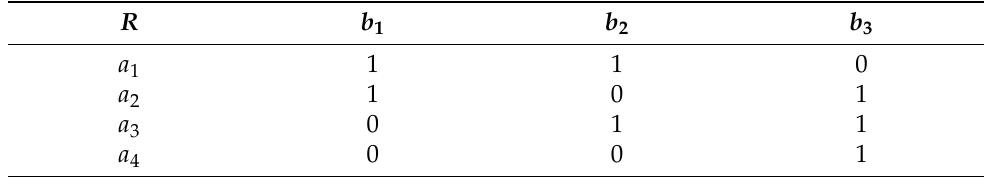
Table 1. Relation of the context of Example 1.